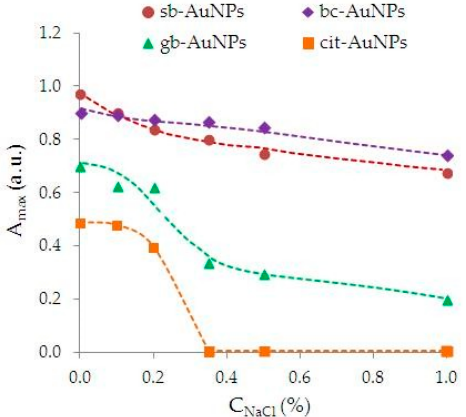
Figure 8. The effect of an NaCl destabilizing electrolyte on the stability of cit-AuNPs and phyto- Figure 8. The e ff ect of an NaCl destabilizing electrolyte on the stability of cit-AuNPs and AuNPs suspensions. phyto-AuNPs suspensions.